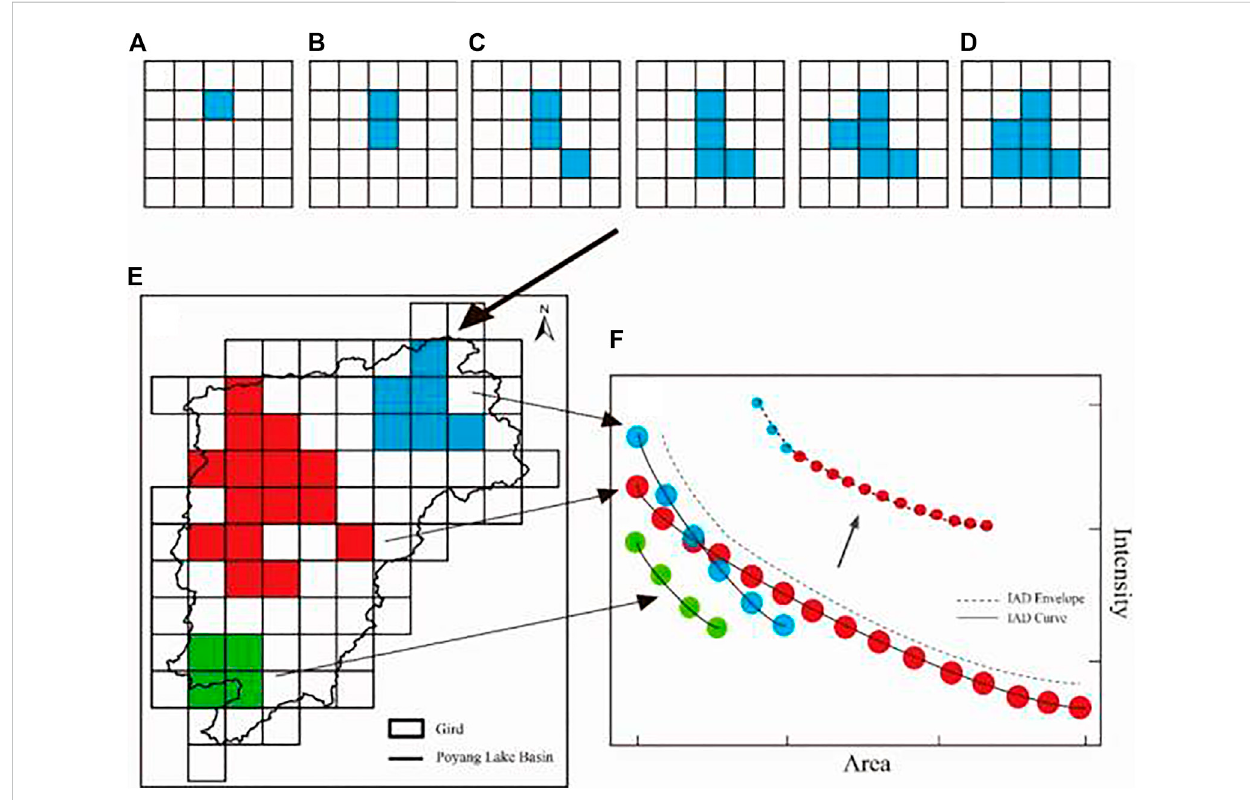
Constructionofintensity-area-duration(I-A-D)curve.( (A – E) :Determinationoftherangeofextremeevents; (E) :TheextremeeventsinPoyangLake Basin; (F) : The IAD curve of all the events.) (Zhan M. J. et al., 2019).